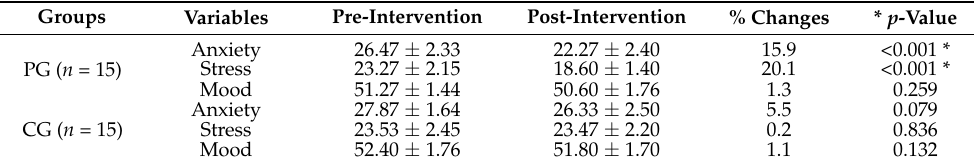
Table 4. Anxiety, stress and mood of PG and CG before and after 6-weeks of intervention.